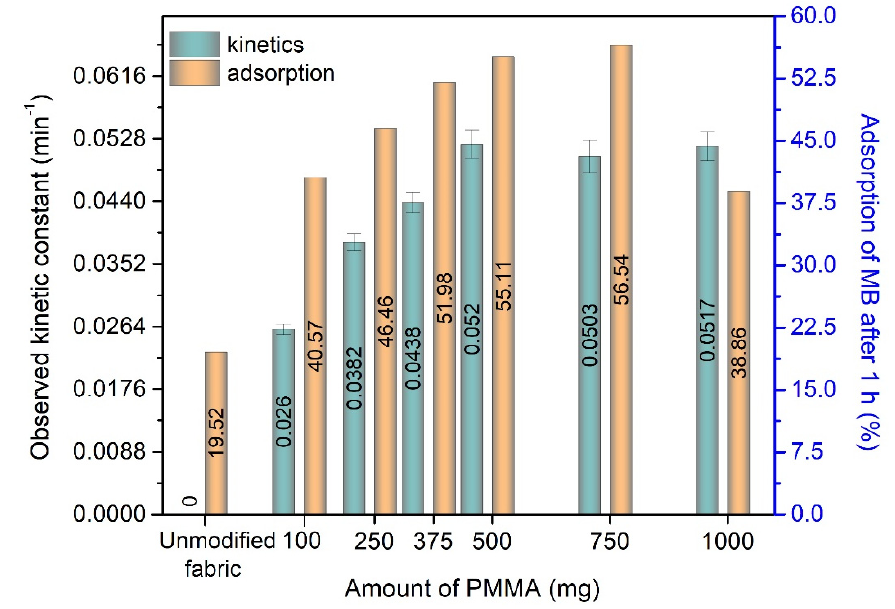
Figure 8. Measured values of adsorption in the dark and photocatalytic activity with confidence intervals under visible light irradiation of the unmodified and modified fabrics.